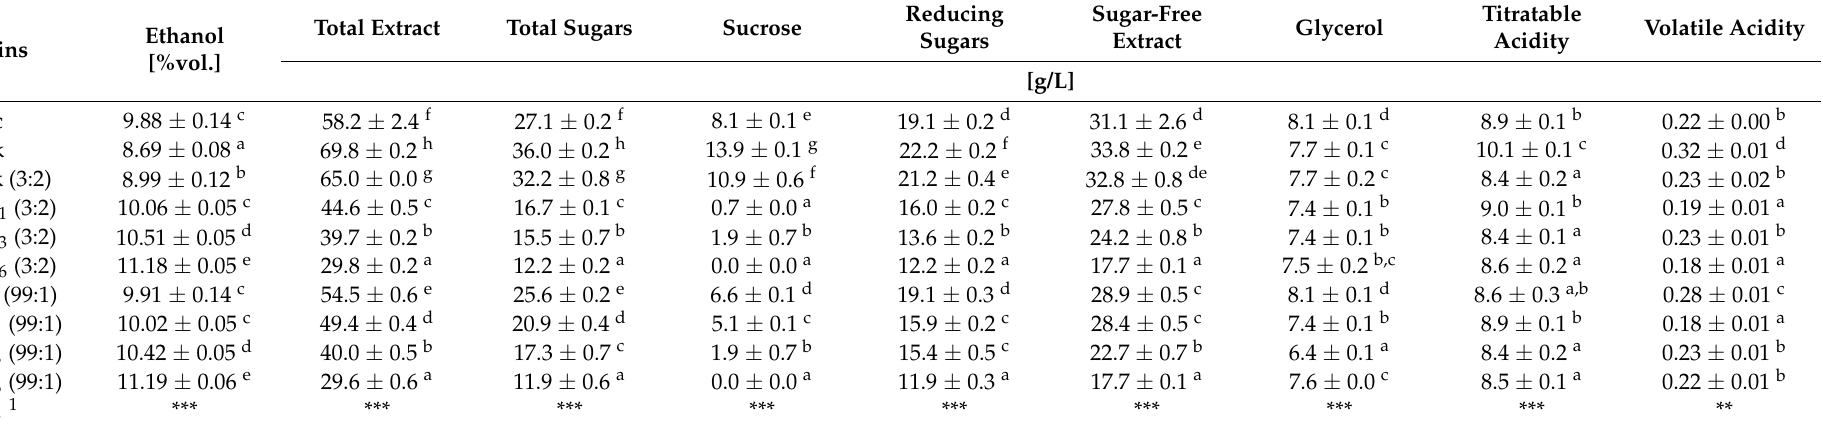
Table 1. The principal oenological parameters of wines obtained using monocultures or mixed cultures of Saccharomyces cerevisiae (Sc) and S. kudriavzevii